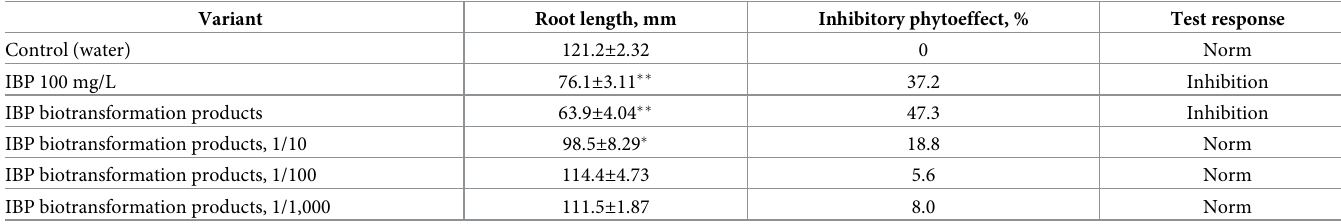
Table 3. Experimental phytotoxicity of IBP and its biotransformation products.